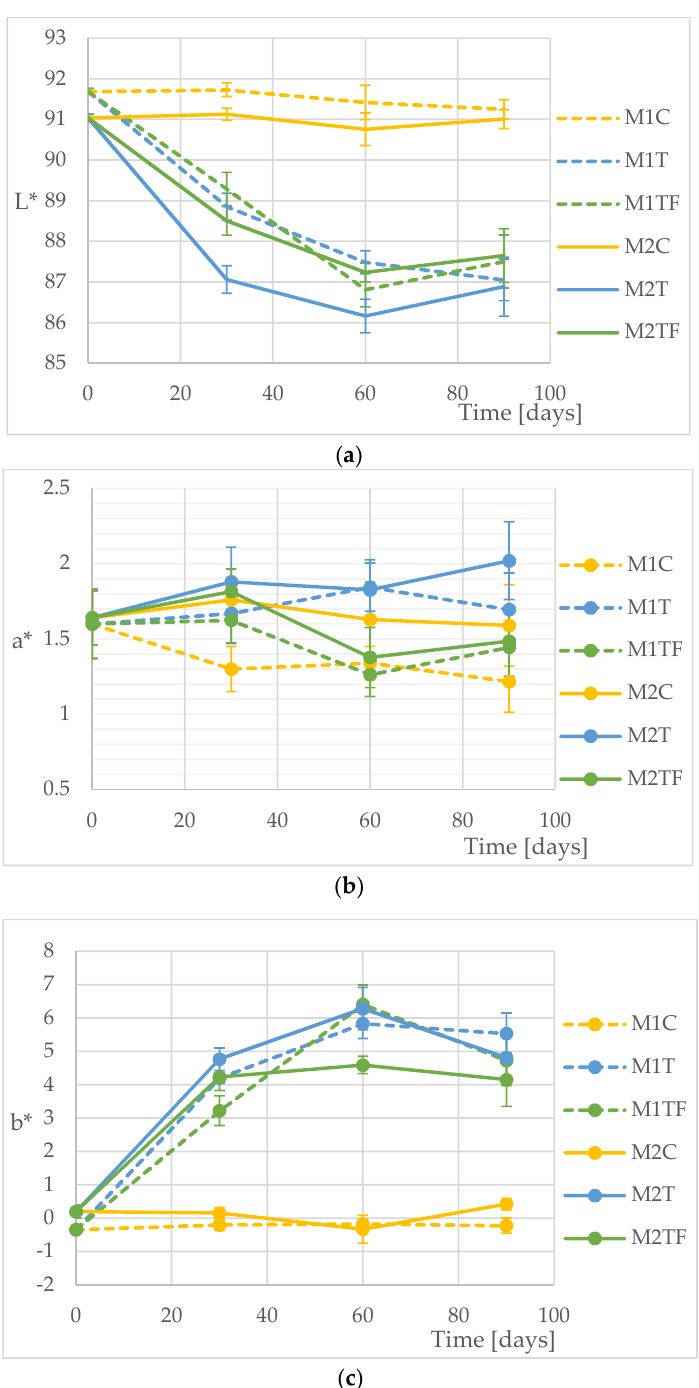
Figure 3. Changes in the CIELAB parameters of the experimental specimens over time: ( a ) the L* parameter (lightness); ( b ) the a* parameter (expression of the red-green wavelengths); ( c ) the b* parameter (expression of the yellow-blue wavelengths). M1—the brackets; M2 –the brackets with the adhesive material; C—the control experiment; T—tea included in the reactions’ cycle; F—the plaque-staining fluid included in the reactions’ cycle. Error bars express the experimental and analytical uncertainty calculated as a standard deviation of the replicates. The experiments were repeated 3 times, and the measurements were performed 10 times per sample. p < 0.05 was considered as the significant difference parameter.